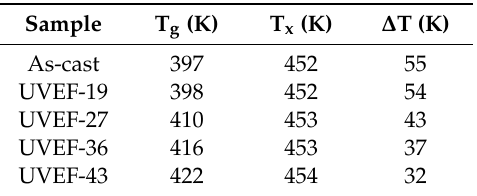
Figure 4. Differential scanning calorimetry (DSC) curves of the as ‐ cast and UVEF ‐ treated samples. Table 1. The values of the glass transition temperature T g and the crystallization temperature T x for as ‐ cast and UVEF treated samples.